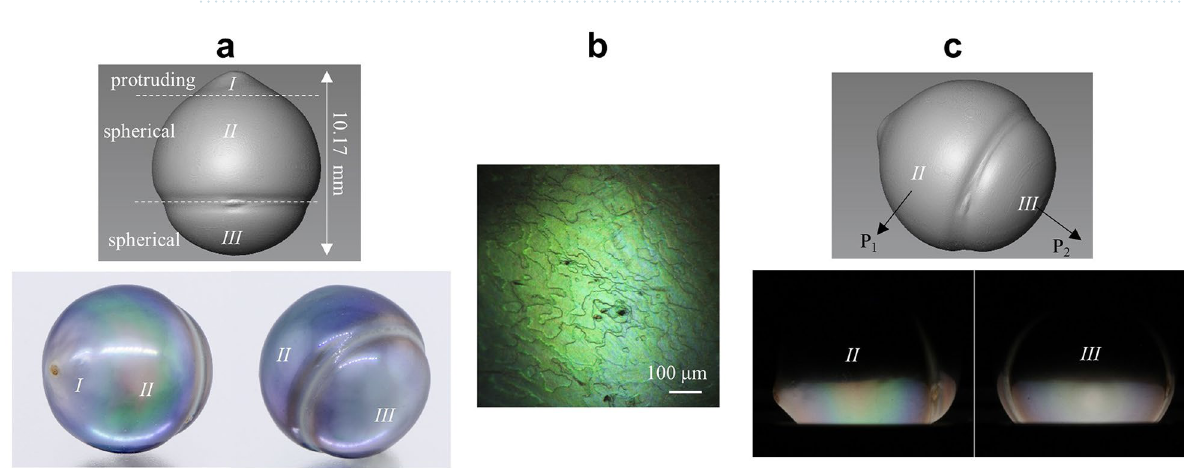
Figure 3. The sample Tahitian pearl used in destructive analysis. ( a ) Its 3D surface model (top) and photographs taken in jewelry lighting box. ( b ) Its surface features observed under optical microscope. ( c ) Its interference patterns observed at points P 1 and P 2